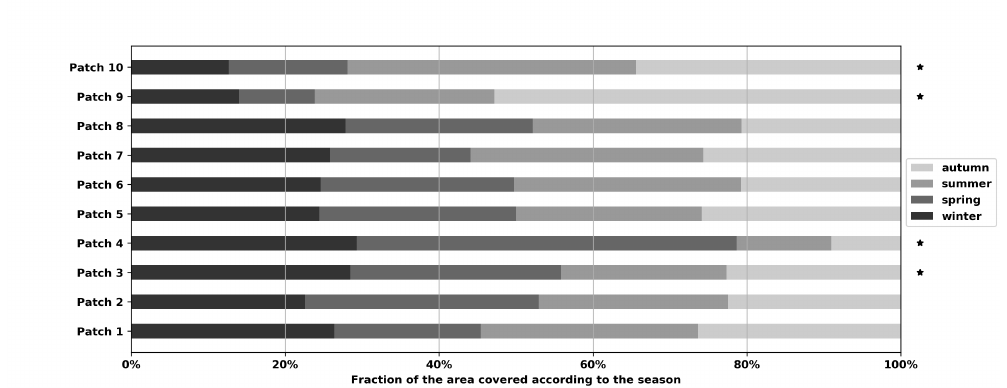
Figure 6. Geographical extent proportion (percents of pixels) of the 10 hydrodynamical patch classes, following the season. Asterisks show patch class with a significant spatial extent variation according to season.